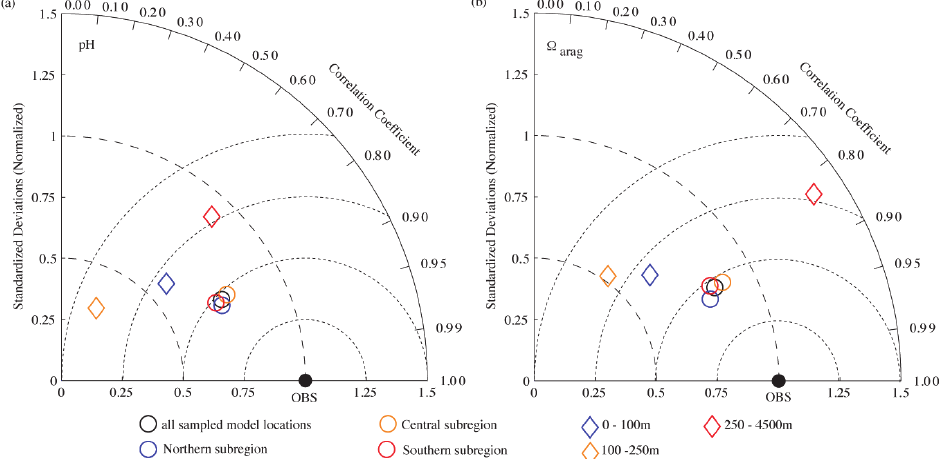
Fig. 5. Taylor diagram (Taylor, 2001) of model simulated (a) pH and (b) (cid:127) arag compared to observations (Feely et al., 2008). A five year average of parameters over May and June (2006–2010) are compared to observations sampled between May and June 2007, for all sampled locations (black), the northern (blue circle), central (orange circle), and southern subregions (red circle), and for 0–100 m (blue diamond), 100–250 m (orange diamond) and 500–5000 m (red diamond). The distance from the origin is the normalized standard deviation of the modeled parameters. The azimuth angle represents the correlation between the observations and the modeled parameters The distance between the model point and the observation point (filled ellipse on the abscissa) indicates the normalized root mean square (RMS) misfit between model and observational estimates.